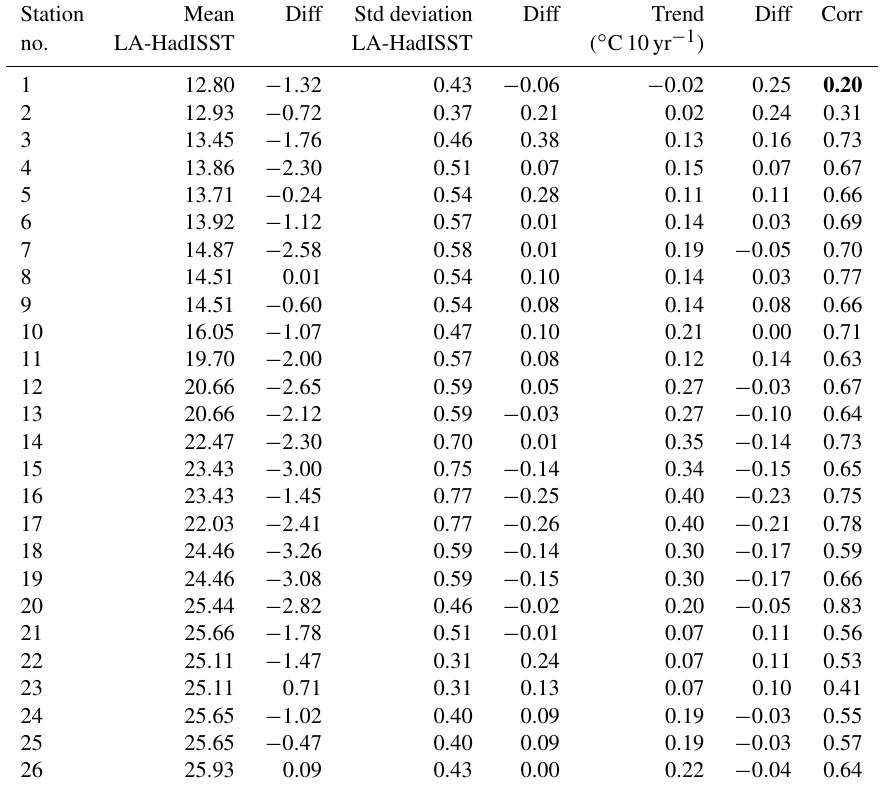
Table 3. Statistics of the time series of the localized SST analysis (LA-HadISST) data series at the 26 stations, as well as the differences (Diff) between statistics of the LH series given in Table 1. The correlation coefficients between LH and LA-HadISST are also calculated (the 90% confidence level is 0.22, without considering serial correlation). Bold numbers indicate that the correlation coefficients do not conflict with the null hypothesis of no